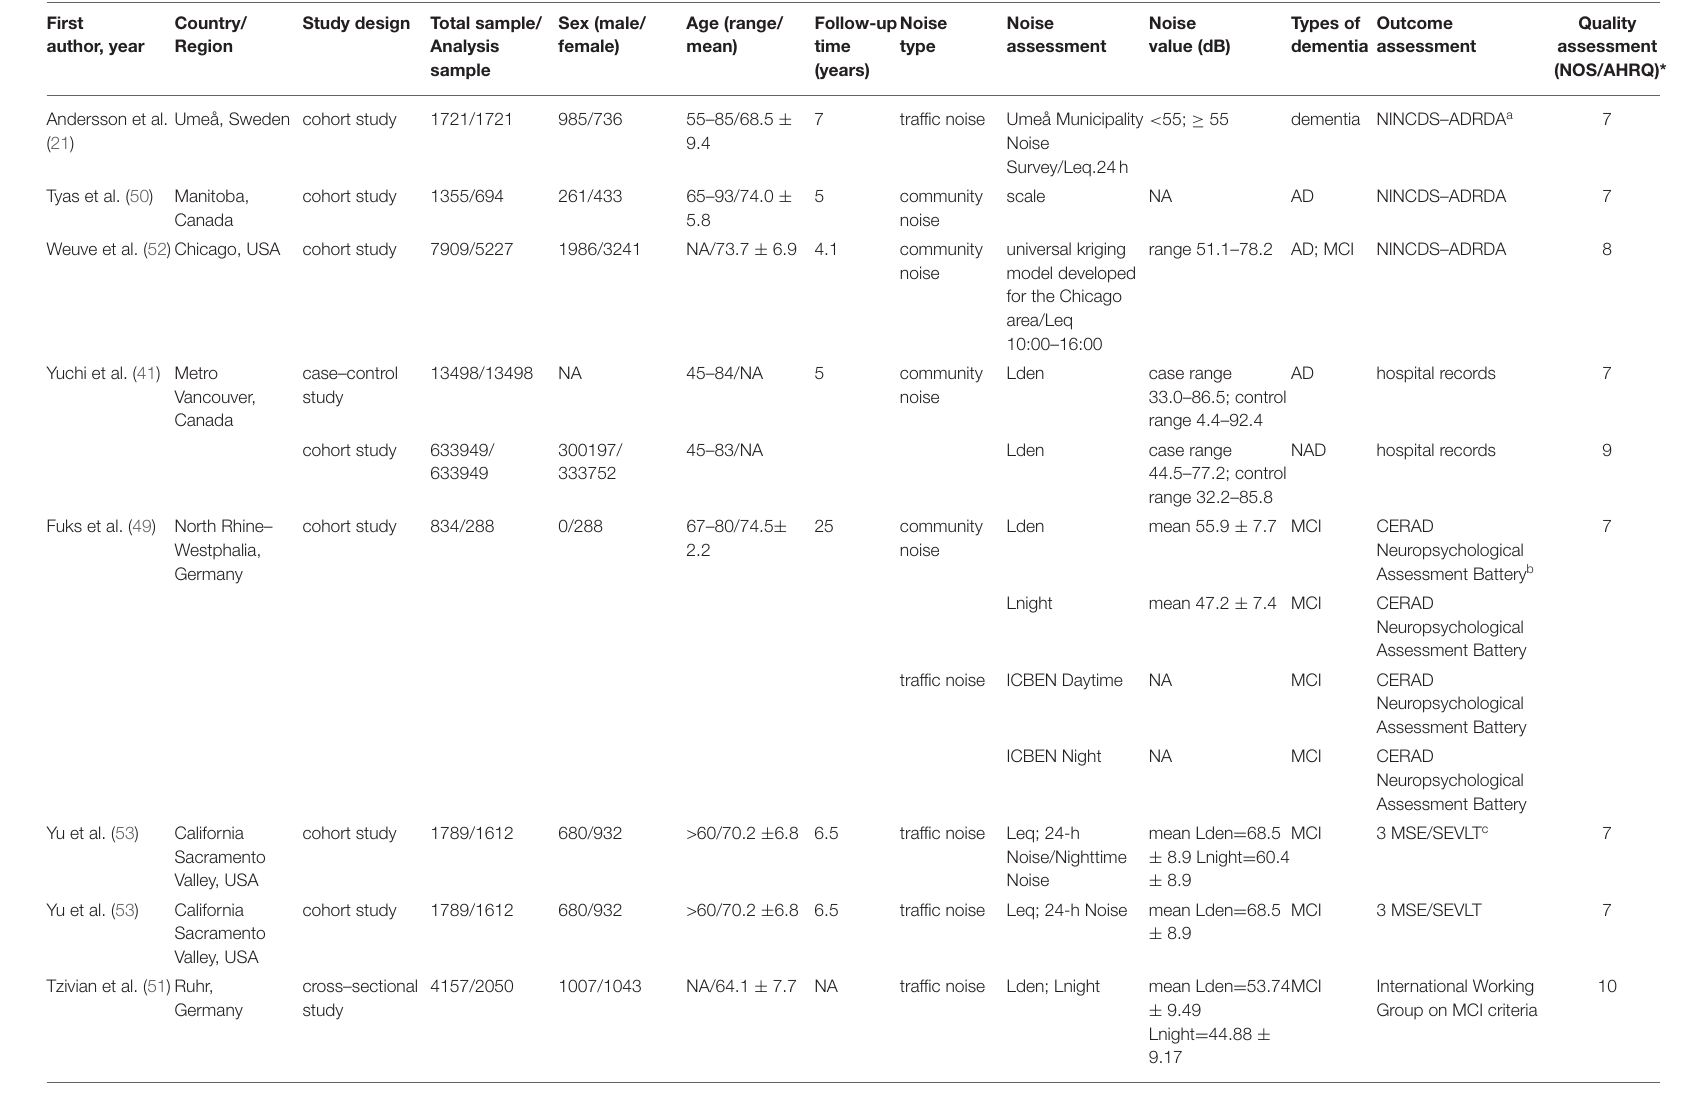
TABLE 1 | Characteristics of the included